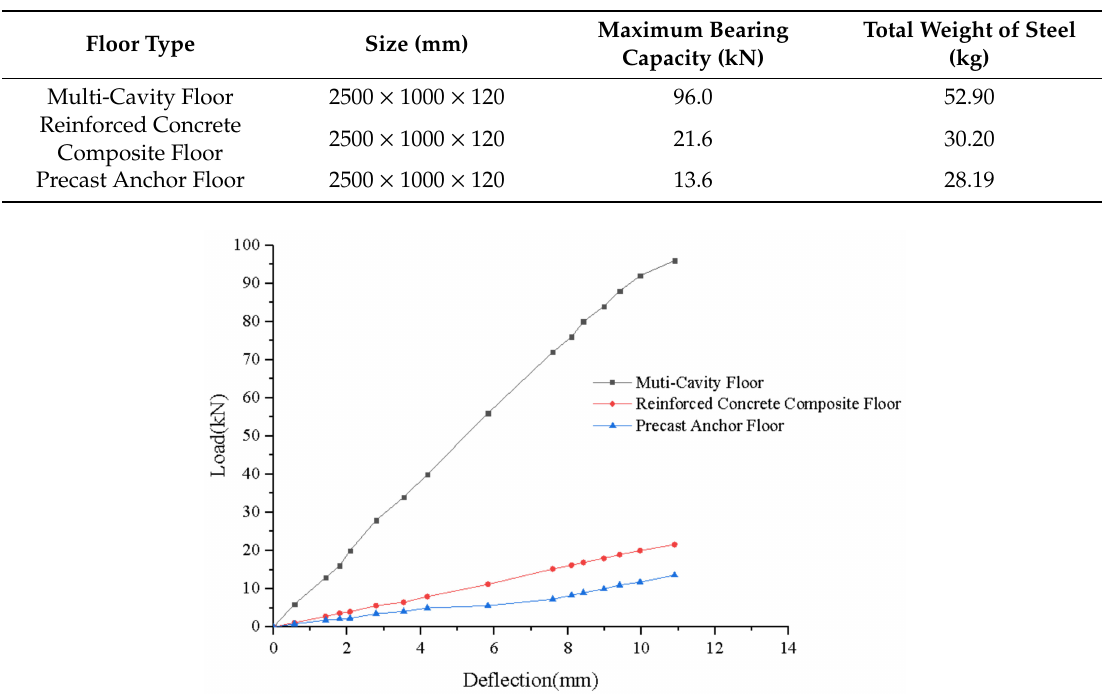
Table 1. Steel consumption of three precast floors.